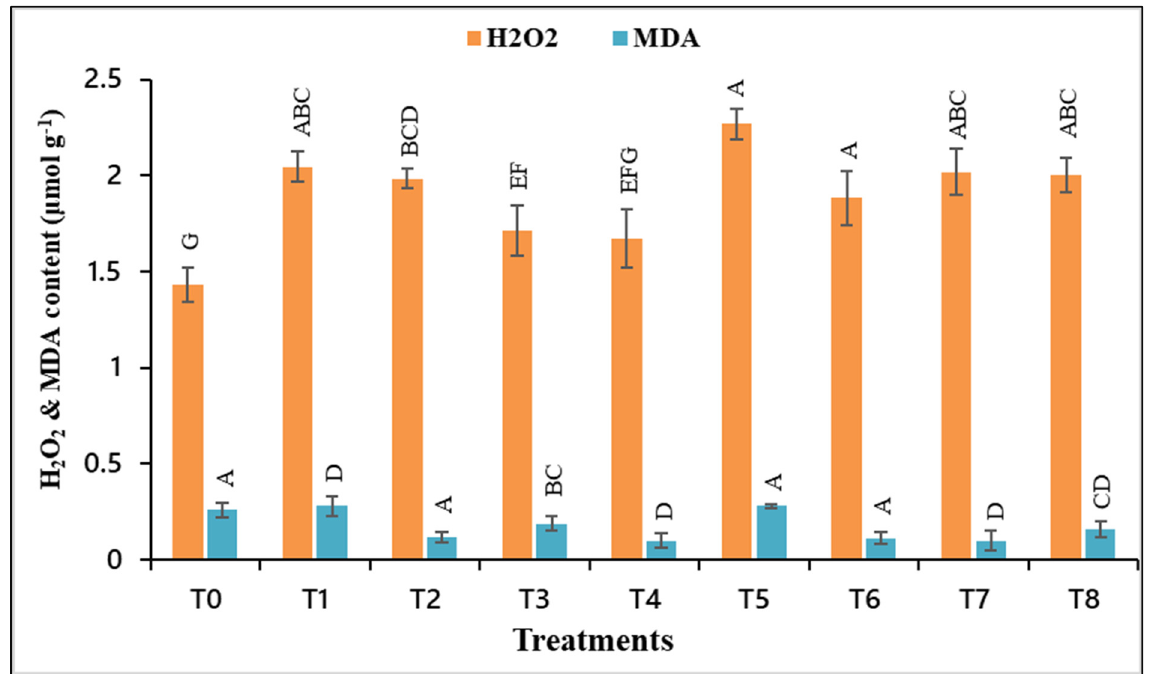
Figure 3. Effect of AsA and/or α -toc on hydrogen peroxide (H 2 O 2 ) or malondialdehyde (MDA) of A. sativa under drought stress. Different alphabetical letters indicate significant differences among treatments at p < 0.05, according to the LSD test. (T0) control: normal watering + 0 mg AsA and α -toc, (T1): 15 days drought + 0 mg AsA and α -toc, (T2): 15 days drought + 200 mg AsA, (T3): 15 days drought + 200 mg α -toc, (T4): 15 days drought + 200 mg AsA and α -toc, (T5): 25 days drought + 0 mg AsA and α -toc, (T6): 25 days drought + 200 mg AsA, (T7): 25 days drought + 200 mg α -toc, (T8): 25 days drought + 200 mg AsA and α -toc.